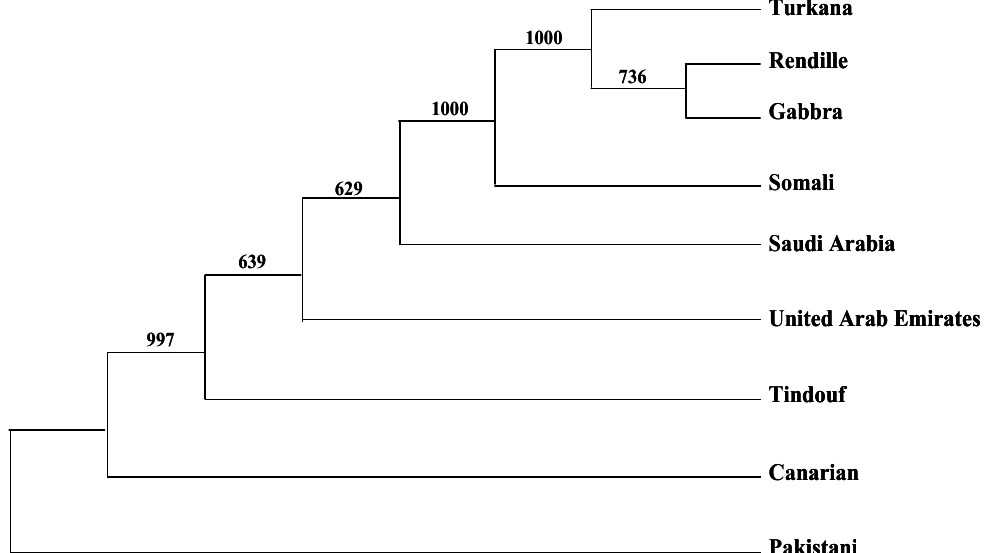
Figure 1. Consensus Neighbor-Joining tree based on the F branches indicate bootstrap values (the number of times the partition of the populations into the two sets separated by that branch occurred among the trees, out of 1,000 trees).